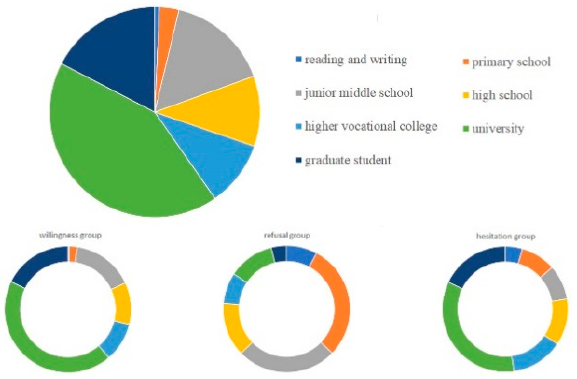
Figure 1. Pie charts of educational level in different attitude groups of COVID-19 vaccines. Table 1. The differences between willing, unwilling, and hesitant attitudes in relation to socioeconomic items.